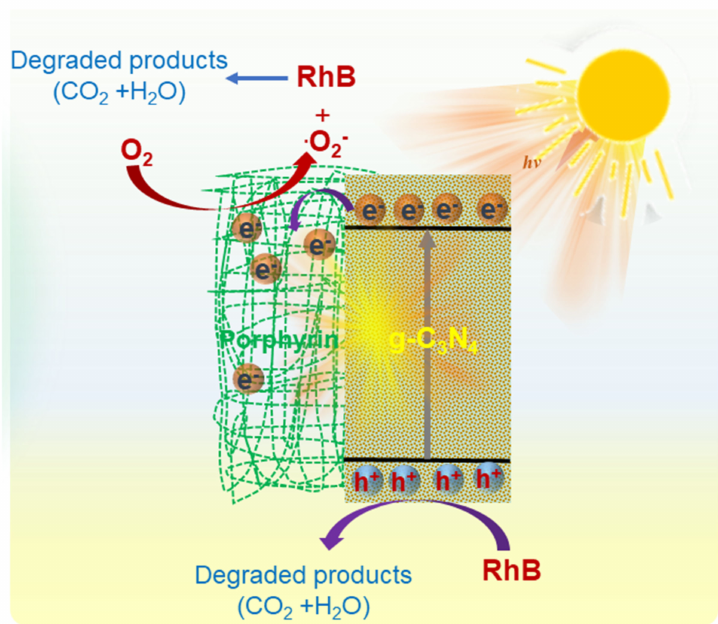
Figure 8. Plausible photodegradation mechanism of the g-C 3 N 4 /porphyrin for the rhodamine B